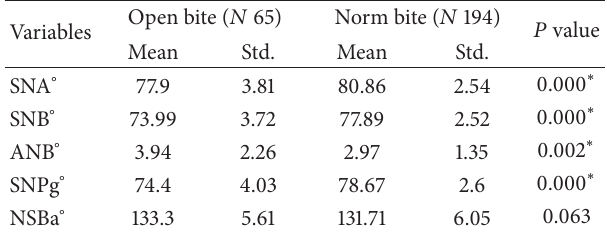
Table 5: The skeletal anteroposterior variables for normal and